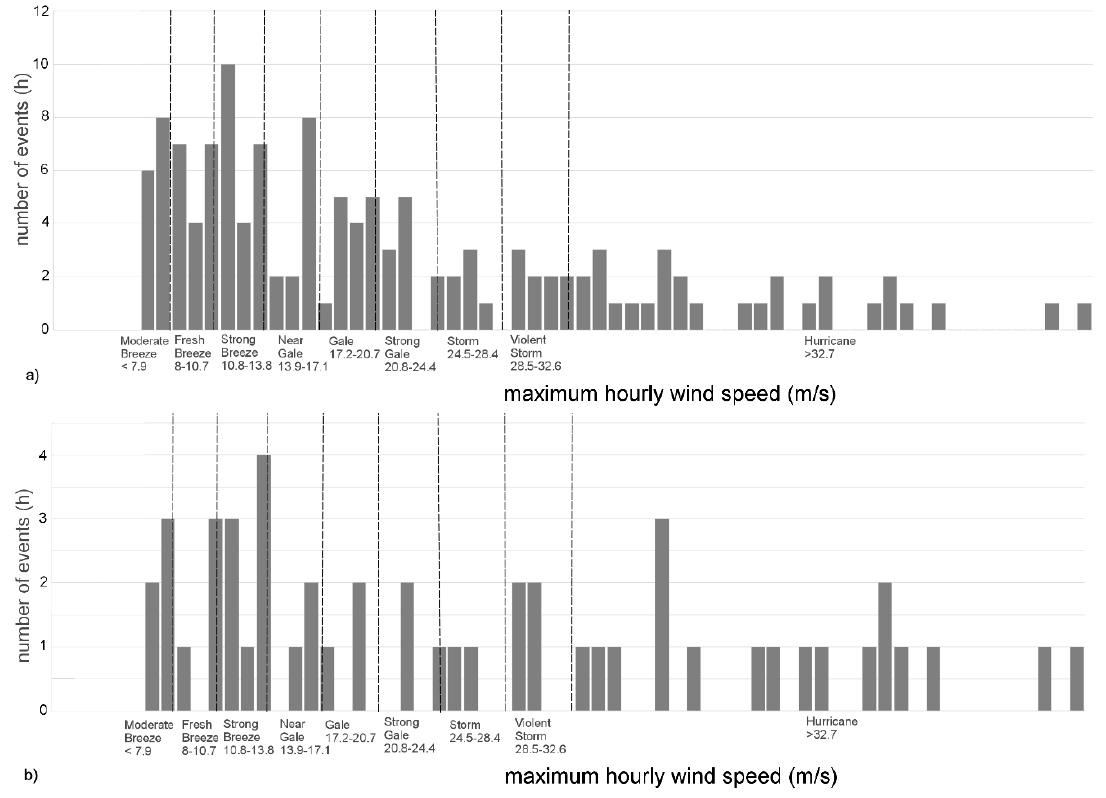
Figure 9. ( a ) Frequencies of the different wind speed classes for all events with hourly rainfall amounts greater than 6 mm; the most frequent events are linked to wind speeds > 6 m/s and <17 m/s corresponding to moderate (<7.9 m/s), fresh (8 – 10.7 m/s) and strong (10.8 – 13.8 m/s) breezes, and near-gales (13.9 – 17.1 m/s); ( b ) frequencies of the different wind speed classes during all events with hourly rainfall amounts greater than 10 mm; some events occurred with strong breezes (10.8 – 13.8 m/s), then with moderate breeze (<7.9 m/s), and several occurred with winds classified as hurricane speeds.